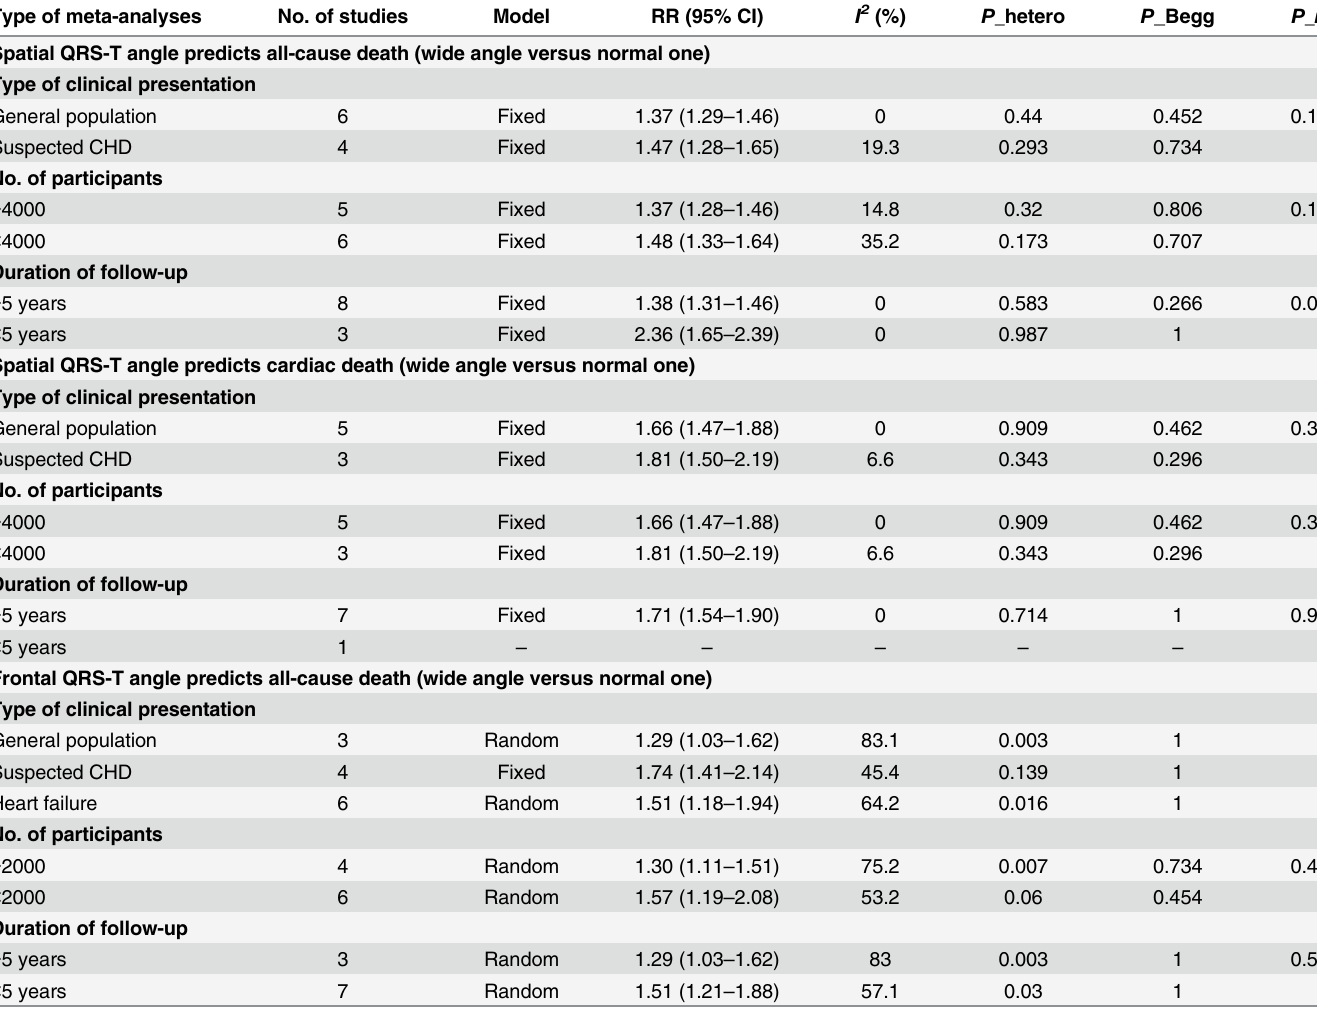
Table 2. Stratified analyses in